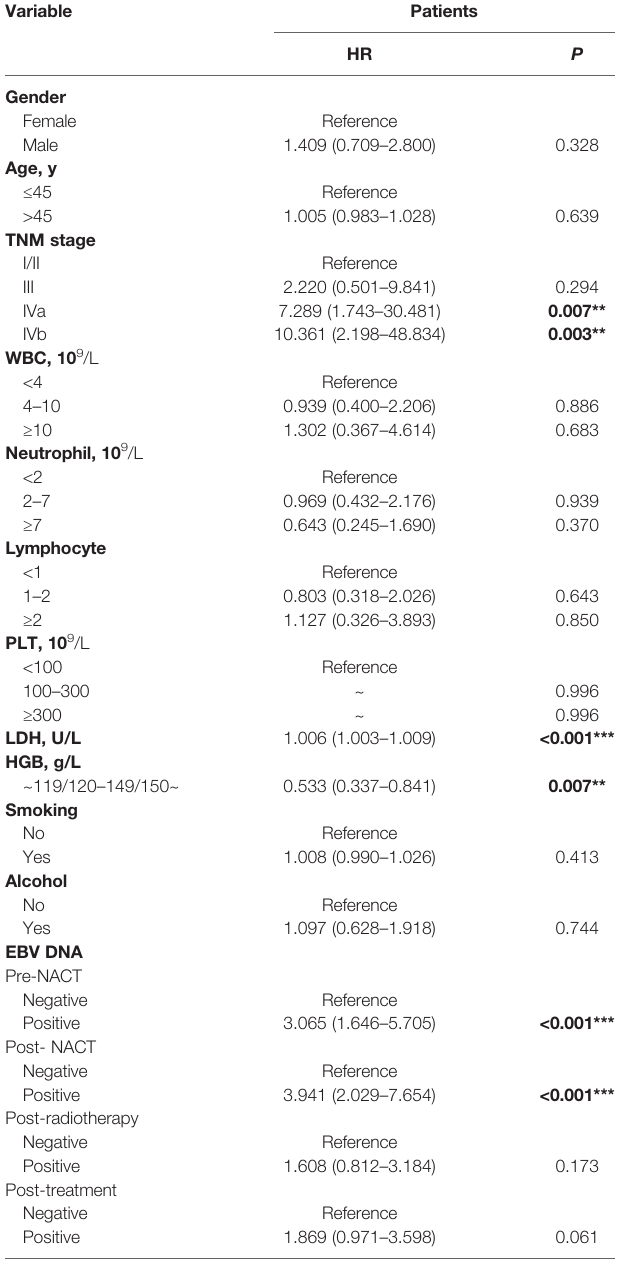
TABLE 3 | Multivariate analysis for the progression-free survival of the primary cohort (N = 206). Variable